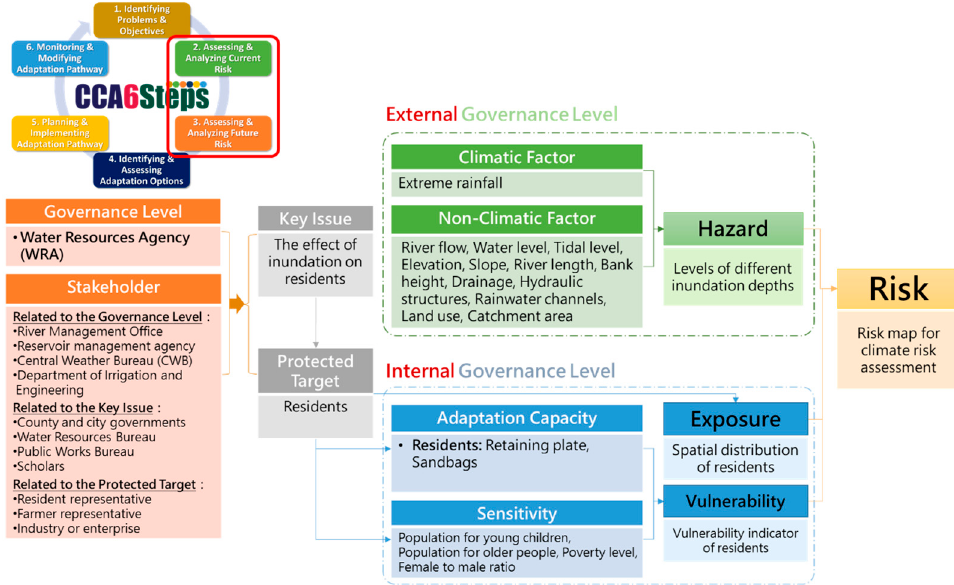
Figure 7. The proposed algorithm of climate risk assessment for investigating the relationship between factors based on Steps 2 and 3 of CCA6Steps.